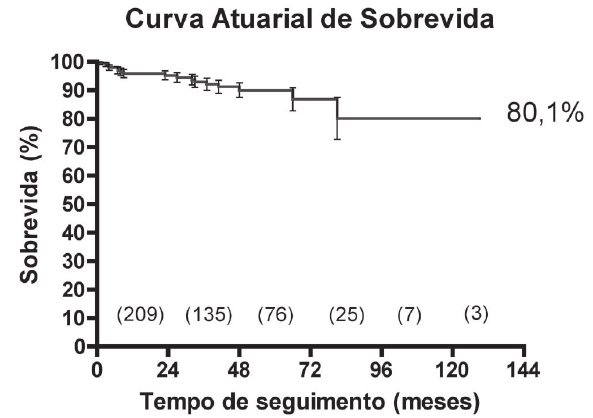
Fig. 2 - Curva atuarial de sobrevida global, nos 282 pacientes submetidos à substituição da valva aórtica por homoenxerto valvar